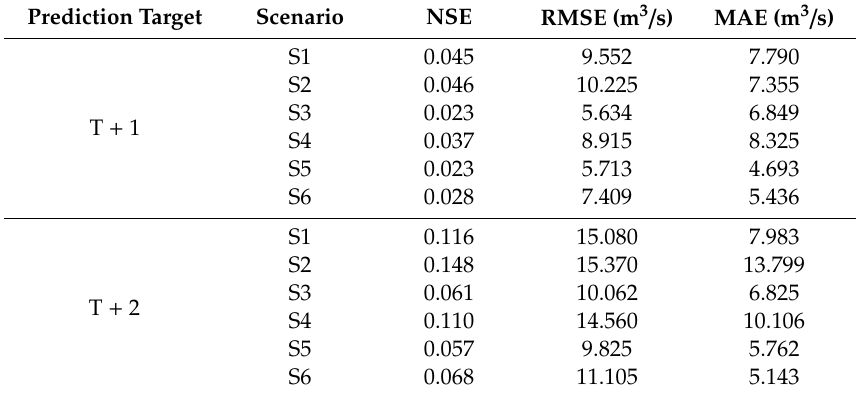
Table5. Timestepstandarddeviationofeachscenarioforone-day-aheadandtwo-day-aheadforecasting in the validation